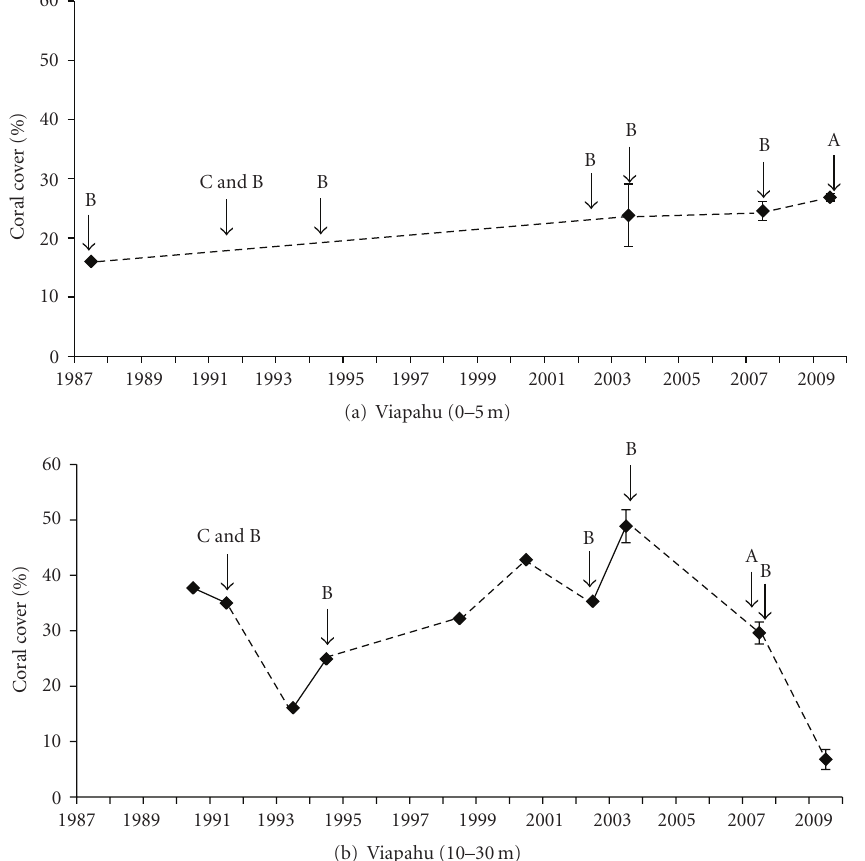
Figure 3: Interannual variation in mean ( ± SE) coral cover in (a) deep habitat (0–30m) and (b) shallow habitats (0–5 m) at the Viapahu reef, Moorea. Dashed lines indicate presumed trend across years for which no survey data is available. The occurrence of outbreaks of A. planci (A), coral bleaching (B), and cyclones (C) is shown.